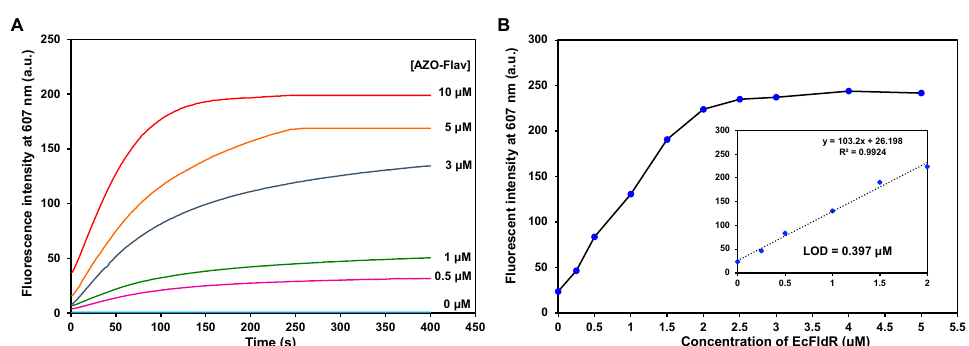
Figure 4. Response of AZO-Flav towards Ec FldR under simulated hypoxic conditions. ( A ) 400 s time course measurement ( λ ex = 540 nm and λ em = 607 nm) of 2 μ M of Ec FldR and 50 μ M of NADPH incubated with AZO-Flav at various concentrations (0 ‒ 10 μ M). ( B ) AZO-Flav (10 μ M) responses to various concentrations of Ec FldR (0.5 ‒ 5.0 μ M) in the presence of NADPH (50 μ M).